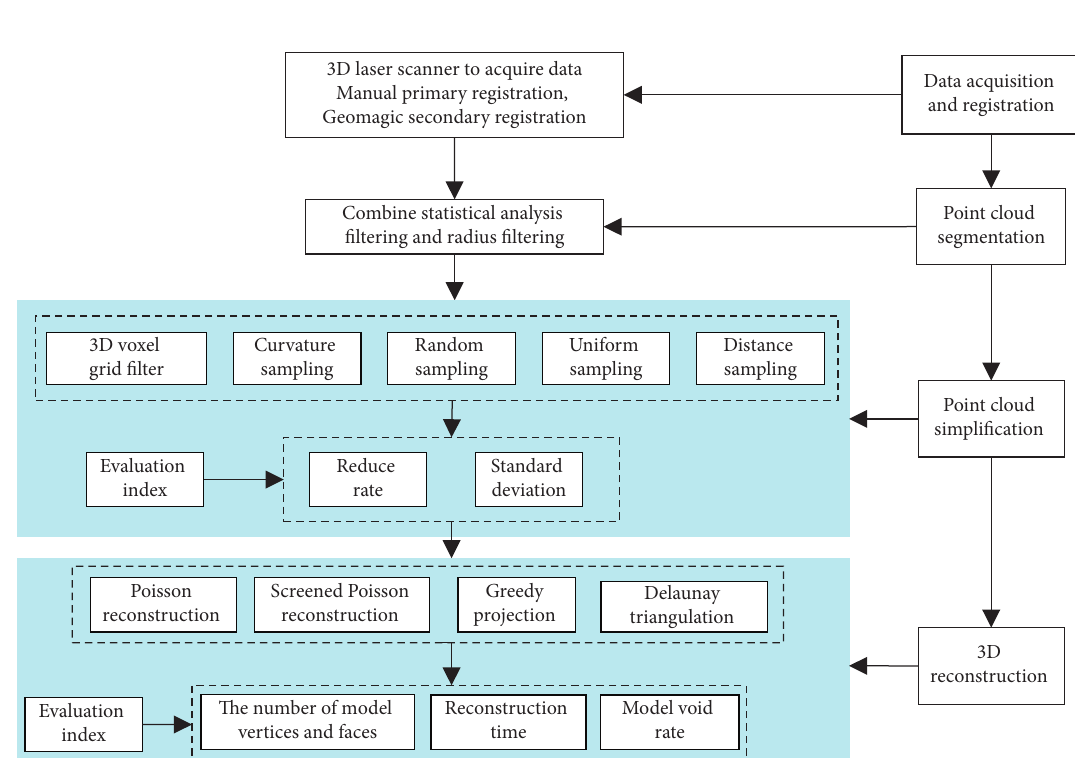
Figure 1: Schematic diagram of point cloud data